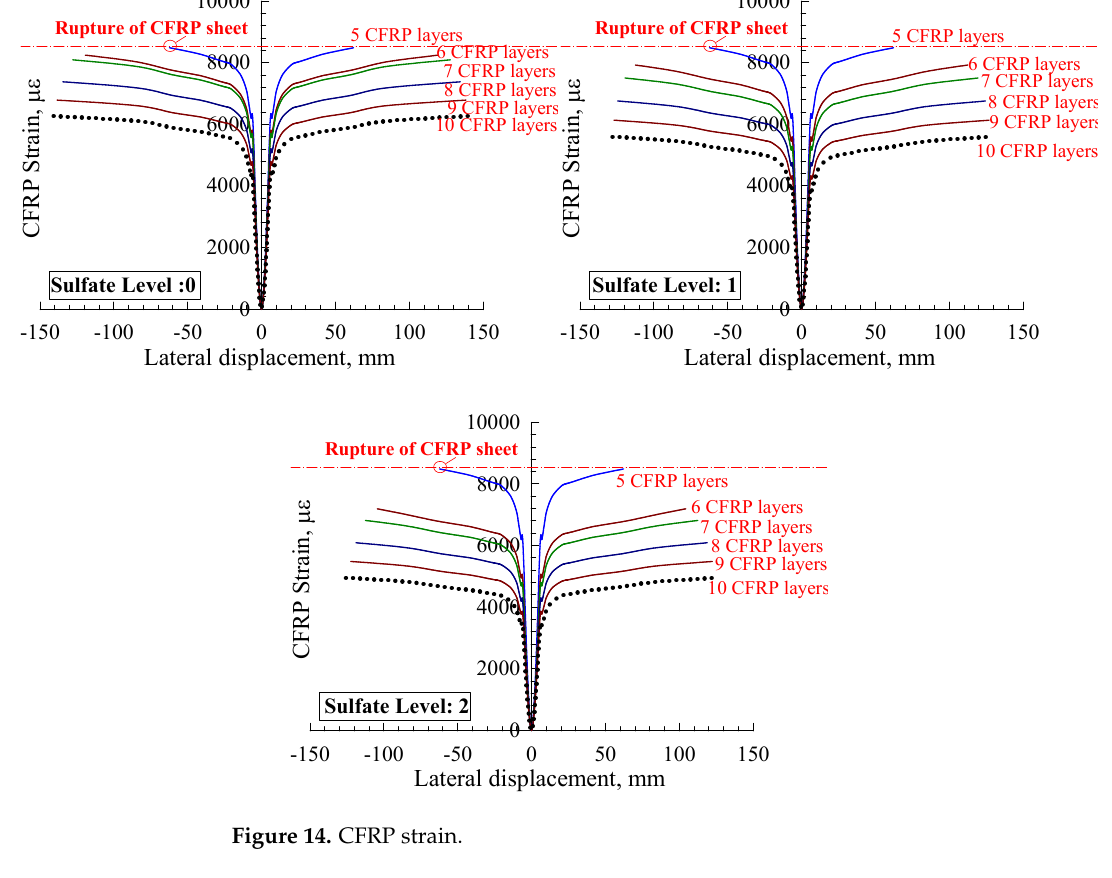
Figure 13. Investigated parameters versus maximum steel strain.